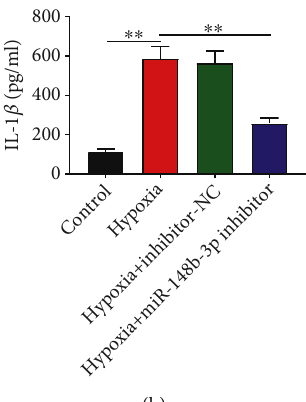
Figure 3: Silencing of miR-148b-3p promotes the viability and represses the apoptosis and in fl ammation of hypoxia-induced H9c2 cells. (a) The expression of miR-148b-3p in hypoxia-induced H9c2 cells was detected by qRT-PCR. (b) The expression of miR-148b-3p in hypoxia- induced H9c2 cells transfected with miR-148b-3p inhibitor/inhibitor-NC was detected by qRT-PCR. (c) Cell viability (OD450) was measured by MTT assay. (d) Caspase-3 activity. (e) The protein expression of Bax and Bcl-2 were measured by western blot. (f – h) The levels of TNF- α , IL-6, and IL-1 β were measured by ELISA. ∗∗ P < 0 : 01